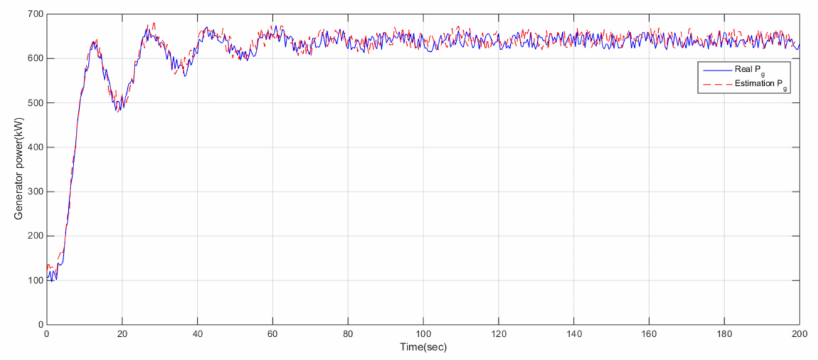
Figure 7. P g with a fault in ω g is present and its